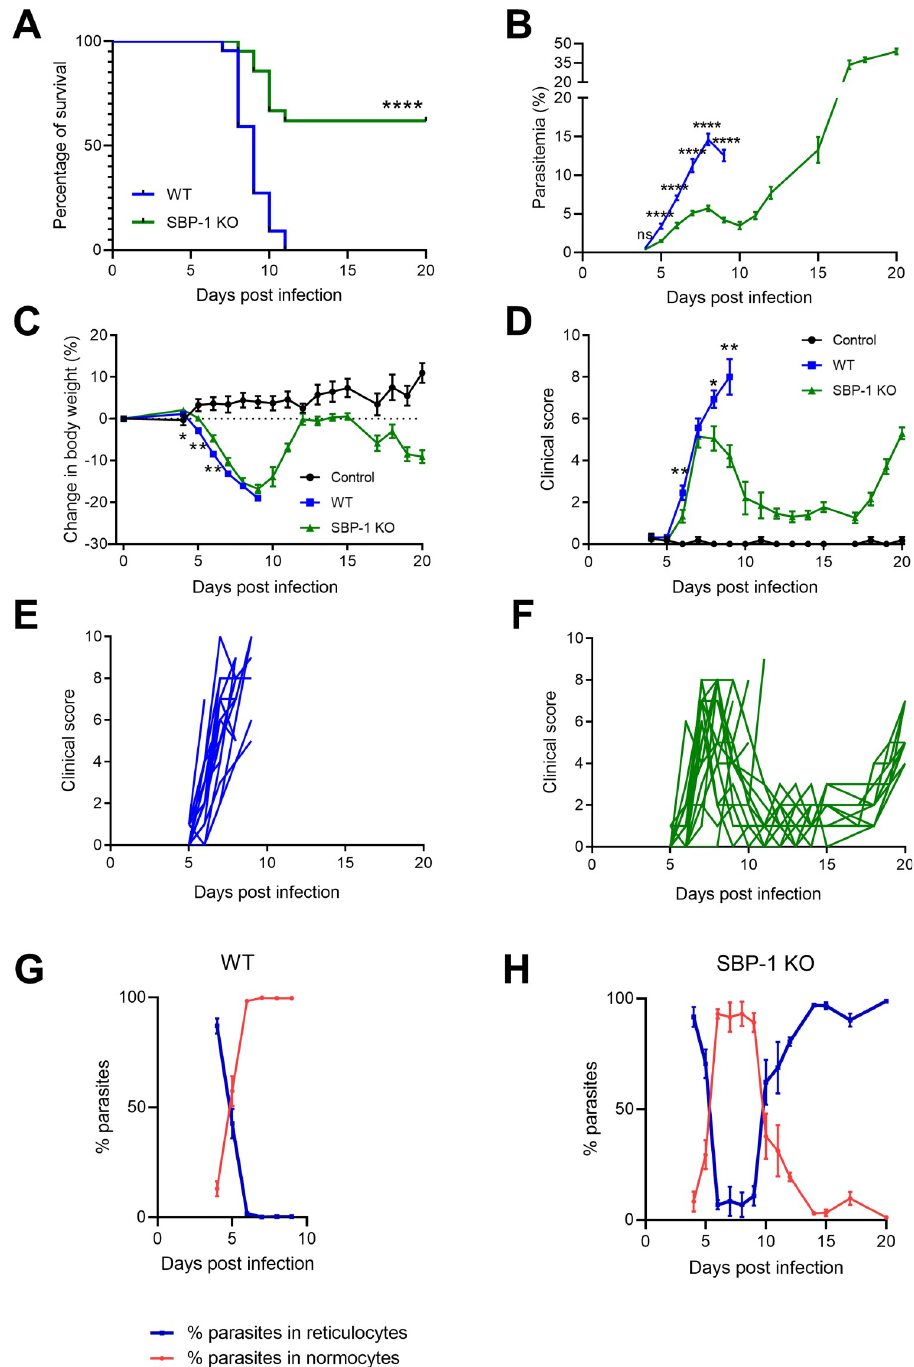
Fig 3. Improved survival of SBP-1 KO infected C57BL/6 mice compared with WT infected C57BL/6 mice. The disease course of WT and SBP-1 KO-infected mice was compared and (A) survival, (B) parasitemia, (C) body weight and (D-F) clinical score were monitored. Clinical score curves of (E) individual WT infected mice and (F) SBP-1 KO infected mice. (G,H) Percentages of parasites in reticulocytes and normocytes were determined at indicated time points by differential counting of blood smears. (B, C, D) Each datapoint represents mean ± SEM. Log-rank (Mantel- Cox) test was used to calculate significant differences between the survival curves. Black data lines denote uninfected control mice. Panel A-F: data of three experiments, uninfected control group: n = 6 per group, infected group: n = 21– 22 per group, panel G-H: data of two experiments, n = 16 per group.